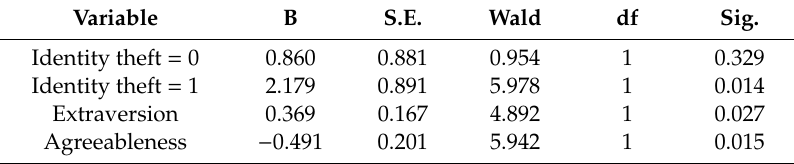
Table 2. Streamlined Model 1—Identity theft: ordinal logistic regression.